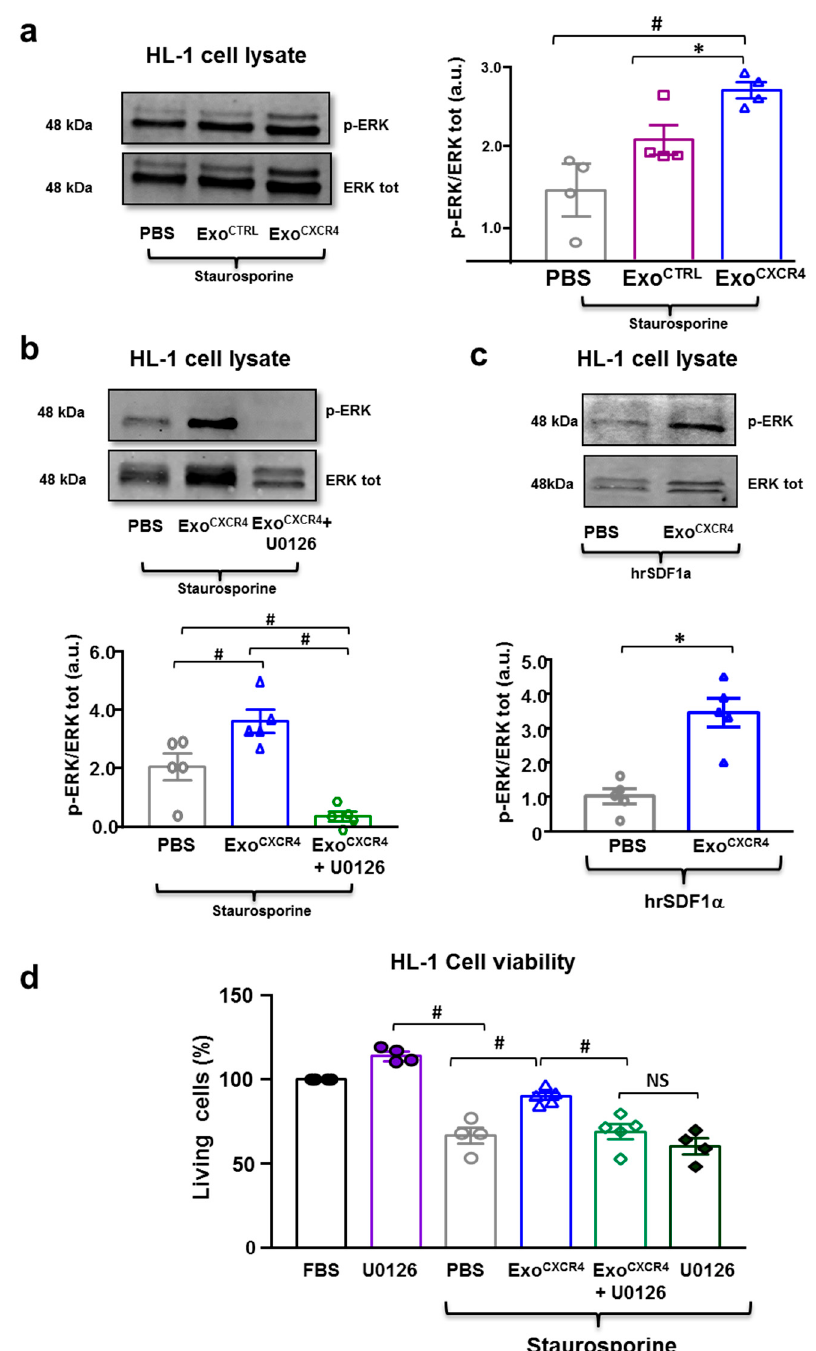
Figure 7. ( a ) Western blot showing pro-survival ERK1/2 phosphorylation in HL-1 CM when Exo CTRL , and Exo CXCR4 were added to the medium in stress-conditions ( n = 4 patients/group) # p < 0.01 (Kruskal-Wallis test nonparametric multiple comparisons with Dunn’s multiple comparison test); * p < 0.05 (two-tailed, paired Student t -test). ( b ) ERK1/2 phosphorylation is prevented by adding the kinases chemical inhibitor U0126. ( n = 5 patients/group for Exo CTRL and Exo CXCR4 ; n = 5 repeated measurements for PBS) # p < 0.01 (one-way analyses of variance-ANOVA with post-hoc multiple comparisons using the Tukey-Kramer multiple comparisons test for paired parametric comparisons). ( c ) Human recombinant SDF-1 α is able to stimulate CXCR4 receptor in mouse HL-1 CM only after these cells have uptaken the human receptor from Exo ( n = 5 patients/group); * p < 0.05 (two-tailed, paired Student t-test). ( d ) Exo CXCR4 are significantly less effective in preventing staurosporine cell death when HL1 CM are treated with the kinases chemical inhibitor U0126, ( n = 5 patients/group for Exo CXCR4 and